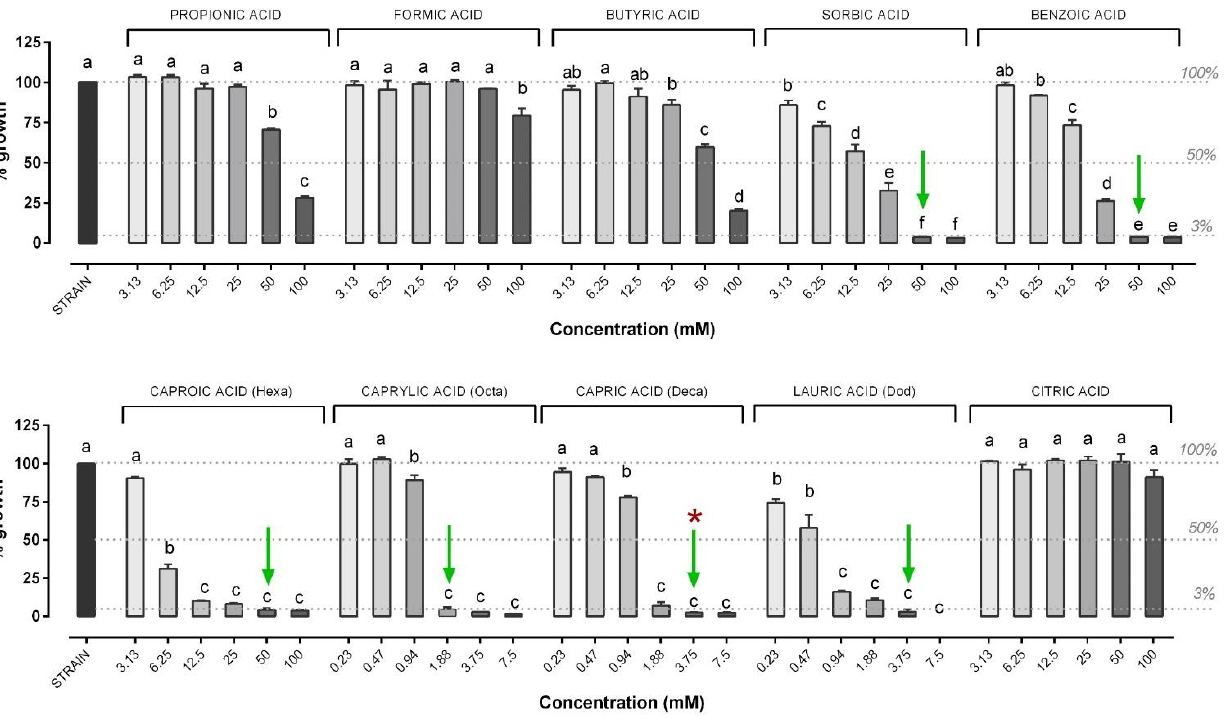
Figure 3. Growth of V. anguillarum strain after 24 h of incubation with the different organic acids (OA). V. anguillarum growth is expressed as a percentage relative to control (strain), and values are presented as the mean ± standard error of the mean (SEM) ( n = 3). Data within each OA were analyzed with one-way ANOVA (including the strain value) and columns with different letters were significantly different ( p ≤ 0.05). Concentrations of each compound are reported in the X axis, while the percentage of growth in the Y axis is reported compared to control. The dashed lines indicate (from top to bottom): control strain level (set as 100% of growth), 50% of growth compared to control (possible OA concentrations able to inhibit 50% bacteria) and the level below which the doses of OA were considered to inhibit bacterial growth (3%). Green arrows indicate minimal inhibitory concentrations (MIC), while red asterisks indicate the minimal bactericidal concentration (MBC) value. When not present, MBC was higher than the highest concentration tested (≥7.5 mM or ≥100 mM). The MBC was defined only for those compounds that showed an MIC value among the tested concentrations.